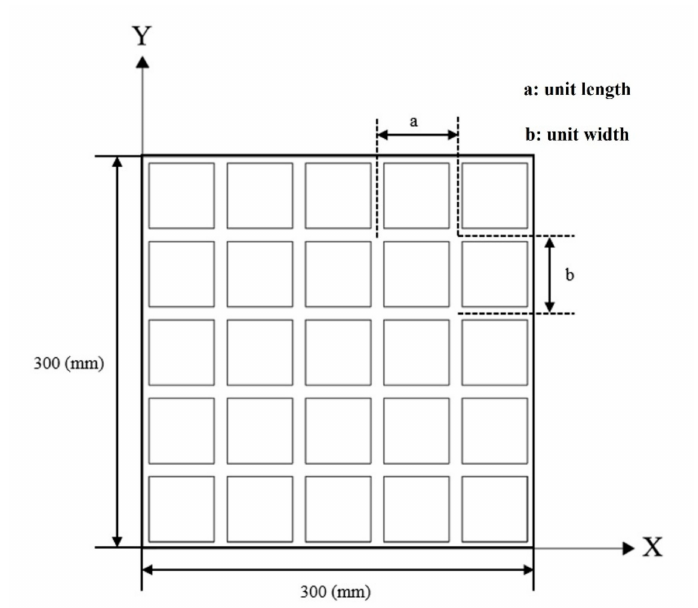
Figure 6. Optimization modeling of the O-type